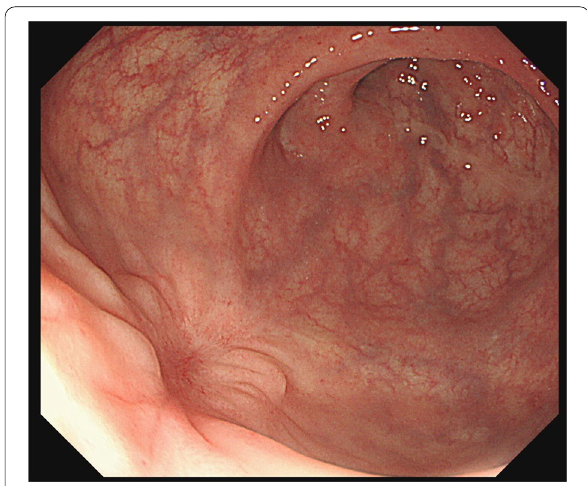
Fig. 3 Colonoscopy confirmed that there were no abnormal findings such as stenosis in the sutured part of the rectal